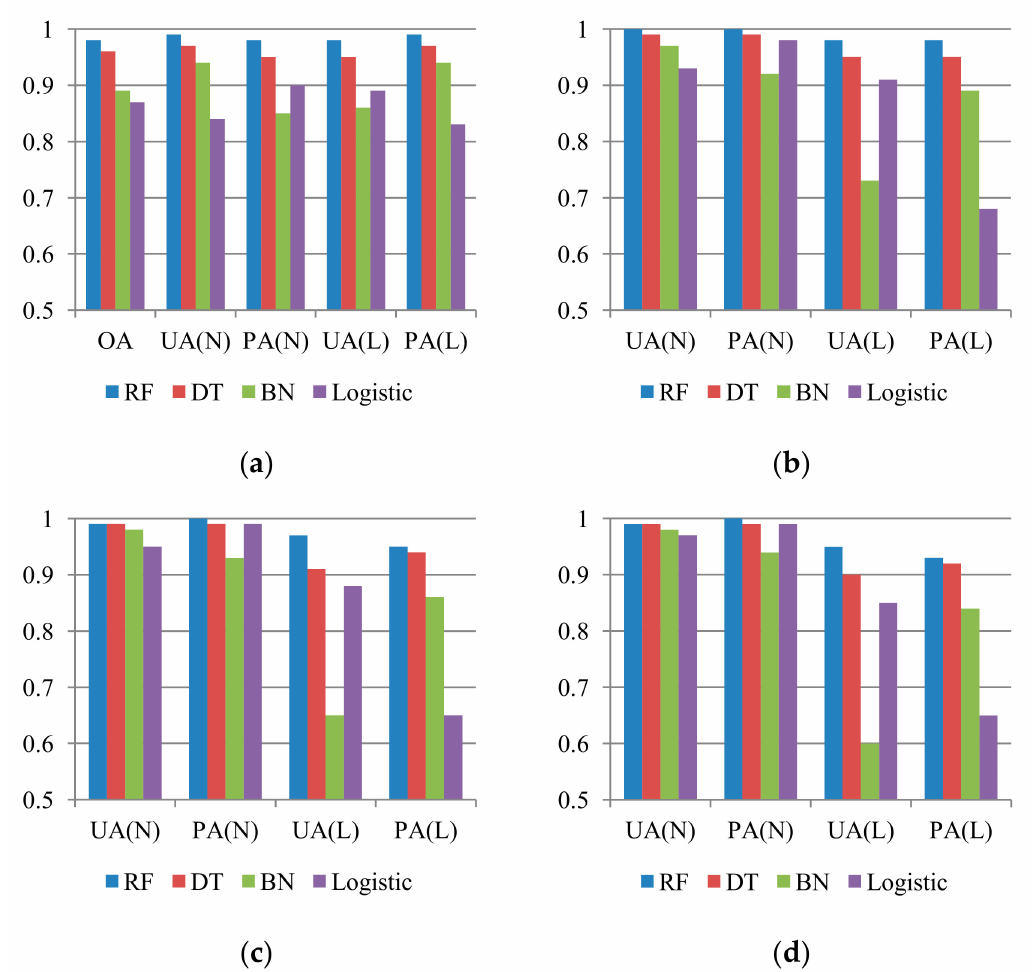
Figure 3. Space-robustness accuracies ( Y axis) of multi-temporal landslide susceptibility assessments, considering di ff erent algorithms and proportions of landslide (L) and non-landslide (N) classes, where RF, DT, BN, Logistic, OA, UA, and PA represent random forests, decision tree, Bayes network algorithms, and logistic regression, overall accuracy, user’s accuracy, and producer’s accuracy,